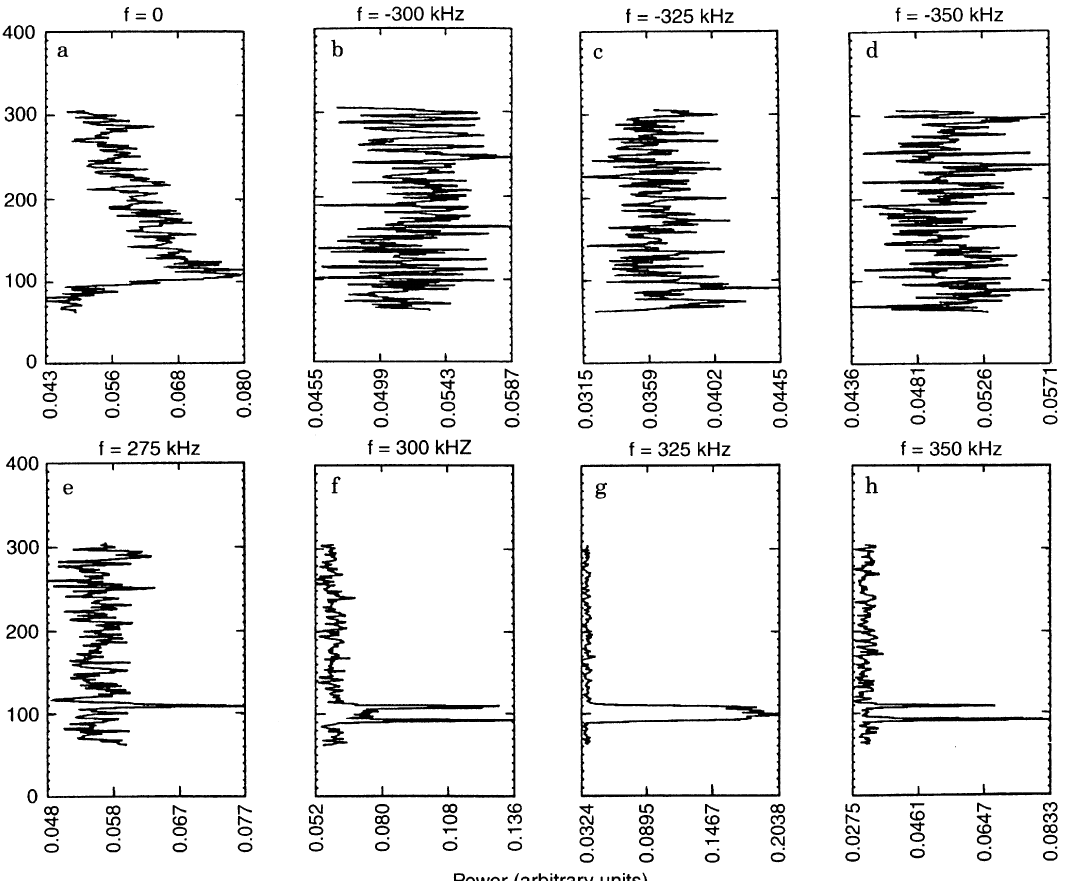
! 350 kHz; e (cid:177) h upshifted channels at f " 275, 300, 325 and 350 kHz. The power is in arbitrary